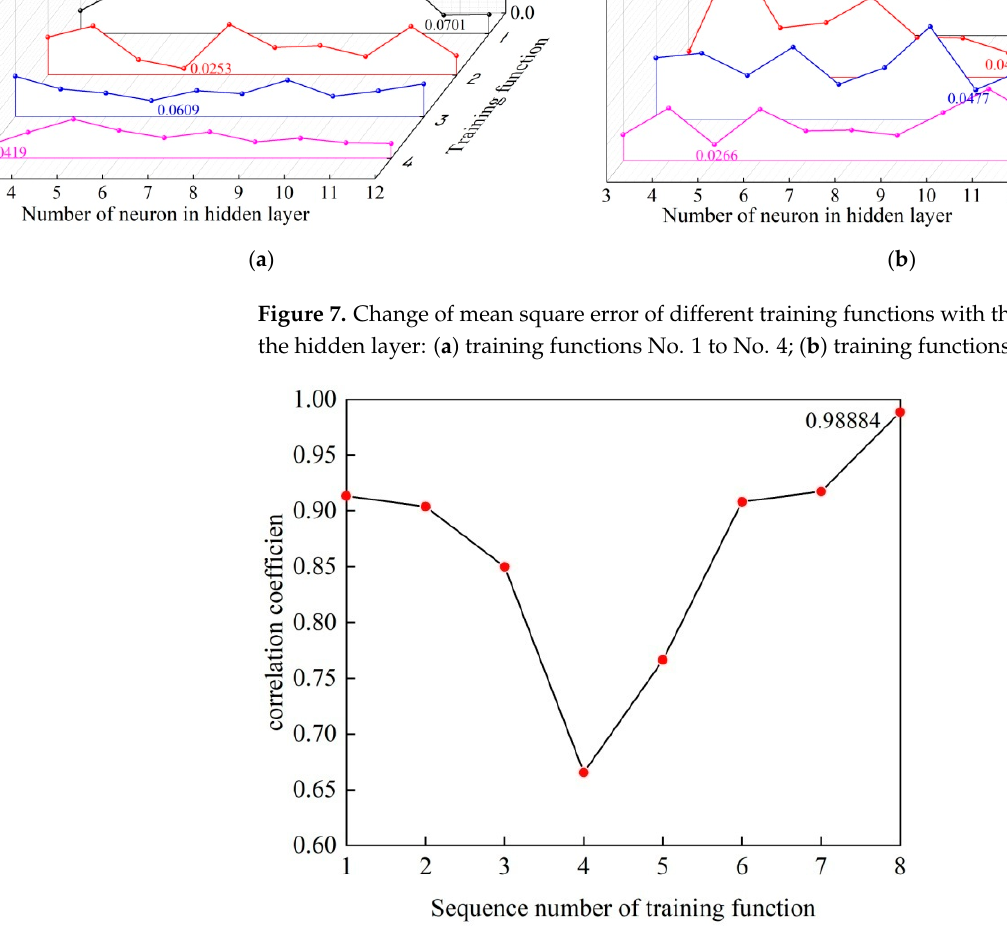
Figure 9. Fitness curve of sample. To further verify the reliability of the obtained network, data No. 1, No. 5, No. 10, No. 15, and No. 20 from the orthogonal test library are randomly selected for testing, and the comparison between the actual values of the test samples and the predicted values of the network is shown in Figure 10 and Table 9. It can be seen from Table 9 that the relative error is controlled within 5%, which meets the accuracy requirements in